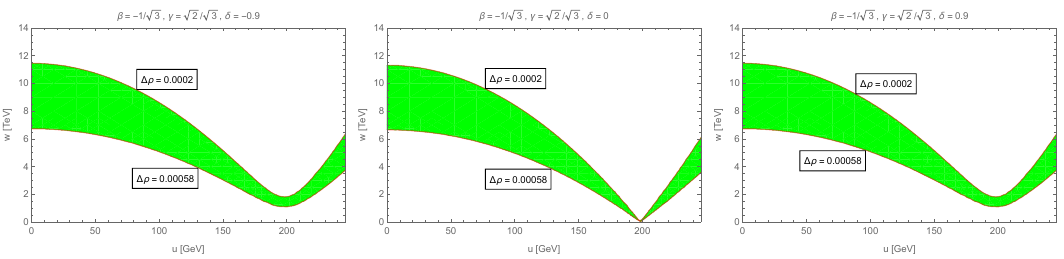
Figure 5 . The ( u, w ) regime that is bounded by the ρ parameter for ( β = 2 / √ 3, c = −√ 2 / √ 3) and w = 0 . 5Λ − and 0 . 9,